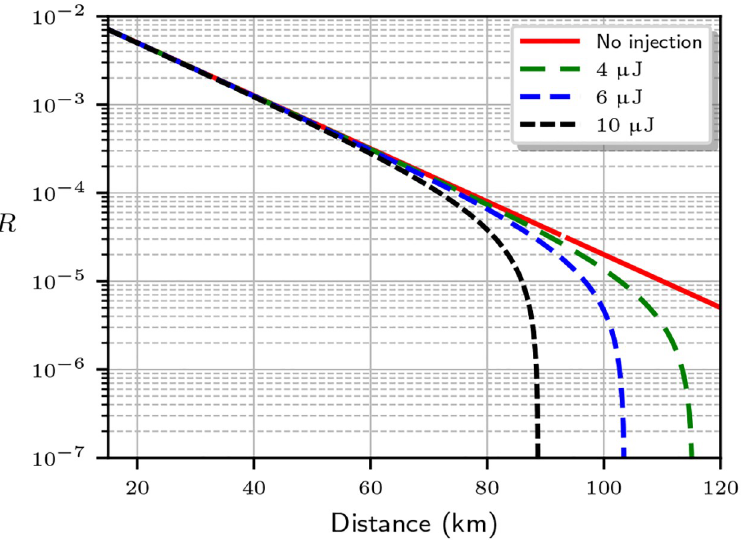
Fig 4. Evolution of the secret key rate R for SARG04 with the link distance for an attenuation of 0.2 dB/km. The red line shows the rate limit estimation Alice and Bob make with their available data. The dashed lines show the corrected rate limit when the mean photon number includes the injected photons from an attacker using lasers with different total energies in the 20 ns data pulses. The maximum distance for a secure key becomes smaller at higher laser